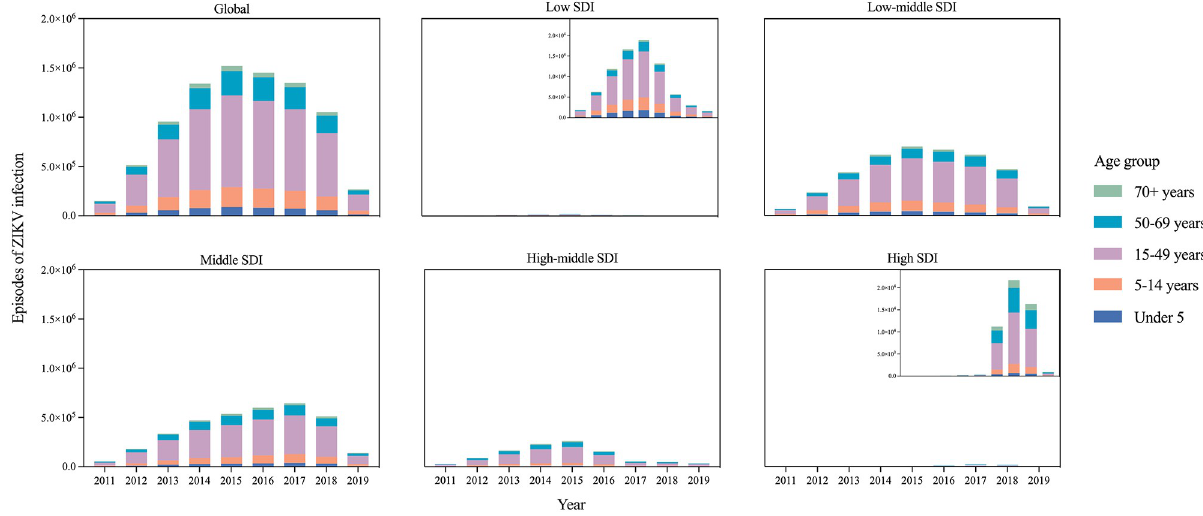
Fig 4. The episodes of ZIKV infection by age group, and by SDI region, from 2011–2019. SDI: Socio-demographic Index.